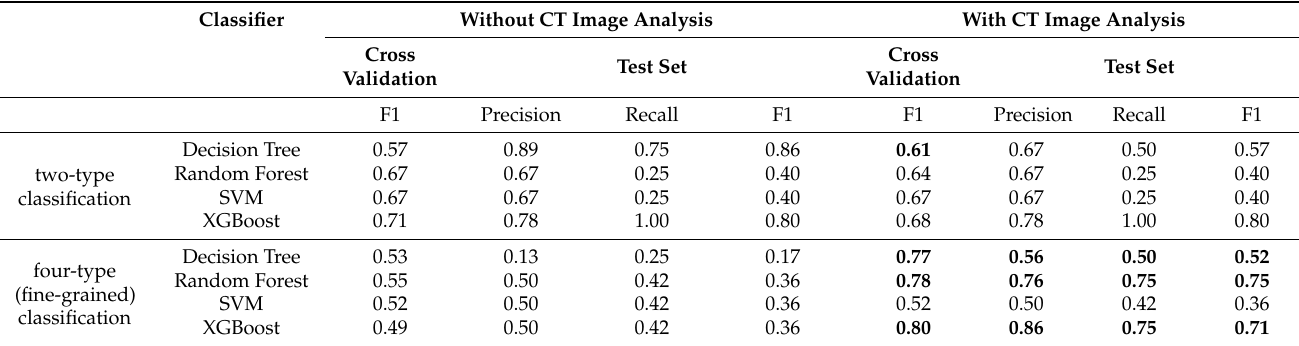
Table 3. Estimation results of machine learning algorithms in two-type classification